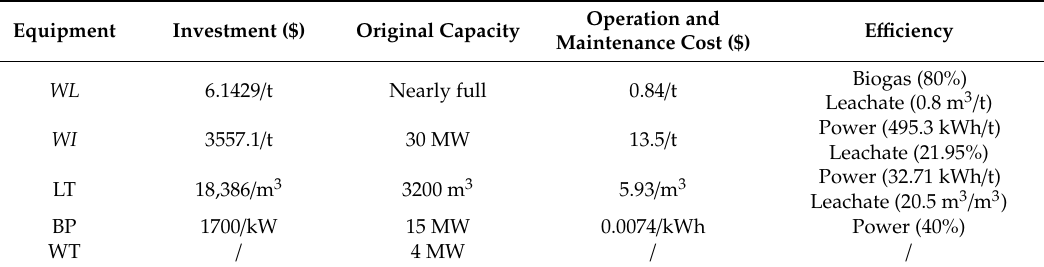
Table 1. Information of the intrinsic equipment.